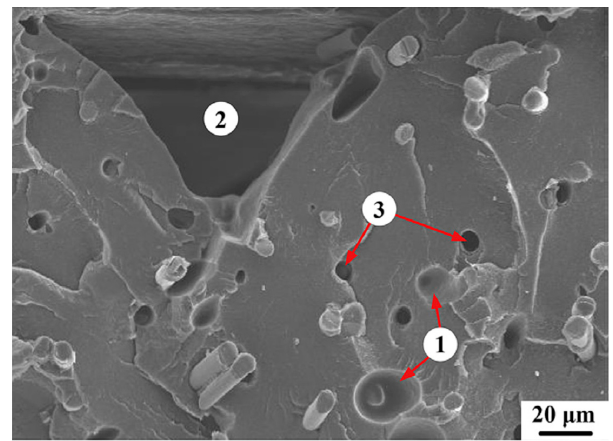
Figure 3. SEM image of different categories of the specimen porosity (carbon fiber content is 10 wt%; carbon fiber length is 150 mm). Reprinted from [19], © 2015, with permission from Elsevier.